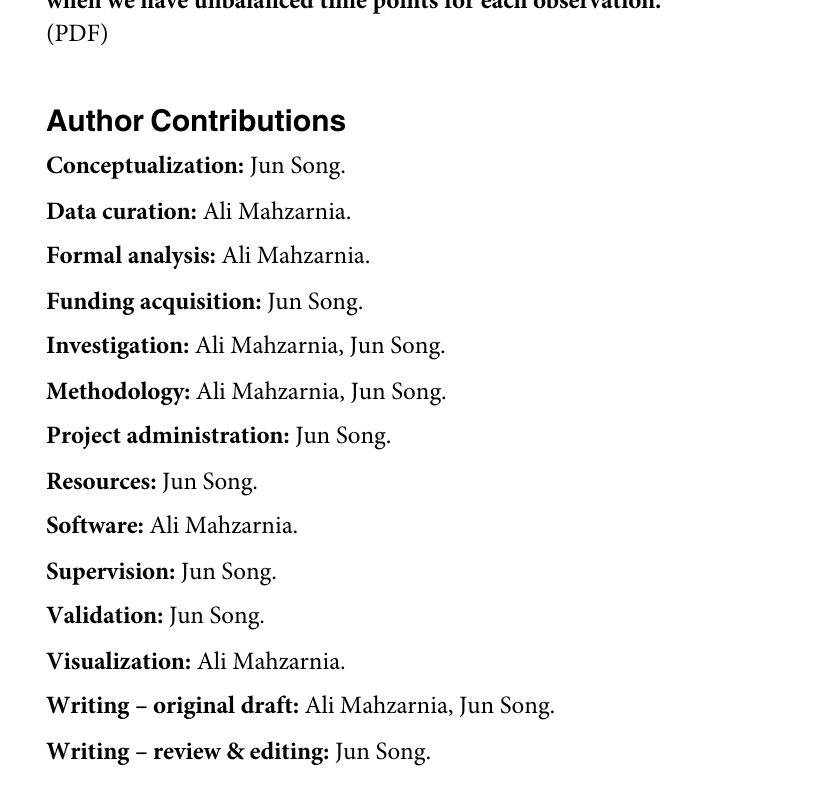
S1 Table. Average test RMSE of different methods under different simulation scenarios when we have unbalanced time points for each observation. S2 Table. Percentages of correct selection in the test set under various simulation scenarios when we have unbalanced time points for each